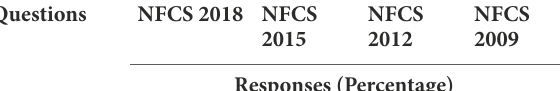
TABLE 2 SFL questions and the